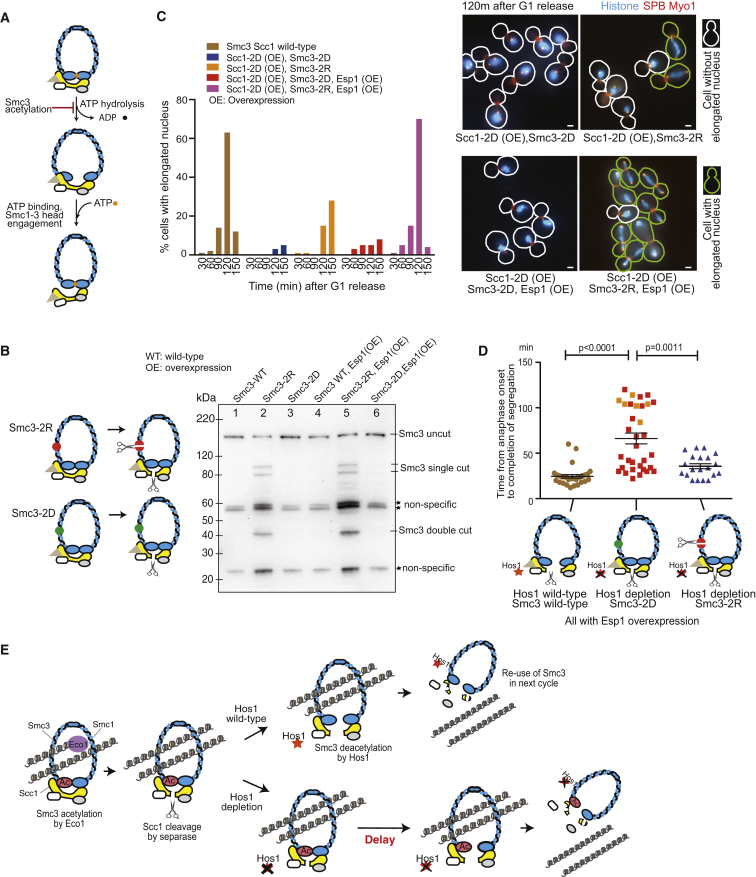
Engineered Smc3 Cleavage by Separase Rescues Efficient Chromosome Segregation in Hos1-Depleted Cells(A) Diagram shows that Smc3 acetylation inhibits ATPase activity of Smc1-Smc3 heads, and Smc1-Smc3 heads remain engaged until ATP is hydrolyzed (top) (Beckouët et al., 2016, Çamdere et al., 2015, Elbatsh et al., 2016, Huber et al., 2016, Murayama and Uhlmann, 2015). In the absence of Smc3 acetylation, ATP is hydrolyzed and Smc1-Smc3 heads are disengaged (middle). Subsequent ATP binding leads to opening of the Smc3-Scc1 interface and destabilizes cohesin association with chromosomes (bottom).(B) Cleavage products are detected in cells carrying SMC3 with separase cleavage sites (SMC3-2R) but not in control (SMC3-2D). Cells with SMC3 wild-type (T12975), SMC3-2R (T11116), SMC3-2D (T11117), SMC3 wild-type PGAL-ESP1 (T12976), SMC3-2R PGAL-ESP1 (T12892), and SMC3-2D PGAL-ESP1 (T12893) were grown in YPA medium containing raffinose. Expression of ESP1 was induced by addition of galactose for 2.5 hr. In all cells, SMC3 wild-type and mutants were tagged with myc epitopes at their C terminus, and the original untagged wild-type SMC3 was deleted, while the original ESP1 was intact. Smc3 was detected by western blotting with an anti-myc antibody.(C) Engineered Smc3 cleavage by separase could rescue chromosome segregation in the presence of Scc1 non-cleavable mutant (SCC1-2D), and this rescue was more efficient when separase was overexpressed. SMC3-2D (T12201), SMC3-2R (T12200), SMC3-2D PGAL-ESP1 (T12827), and SMC3-2R PGAL-ESP1 (T12825) cells with PGAL-SCC1-2D, HTB2-CFP, SPC42-mCherry, and MYO1-mCherry were released from G1 arrest to YPA medium with raffinose. Galactose was added for the last 30 min during G1 arrest and subsequent release from G1 to express SCC1-2D (and to overexpress ESP1 in relevant strains). In all these cells, the original wild-type SMC3 was deleted, while the original ESP1 was intact. Control SMC3 SCC1 wild-type cells (T11219) were treated in the same way. Elongated nuclei were defined as those with two SPBs apart > 3.0 μm; their percentage is shown in graph (left). In representative images at 120 min after release from G1 (right), cells with elongated nuclei are highlighted with green outlines.(D) Engineered Smc3 cleavage by separase rescues timely chromosome segregation in Hos1-depleted cells. HOS1 SMC3 wild-type (T12986), hos1-aid SMC3-2D (T12565), and hos1-aid SMC3-2R (T12566) cells with PGAL-ESP1, HTB2-CFP, Spc42-mCherry, and Myo1-mCherry were treated, and images were acquired as in Figure 1C. Time from anaphase onset to completion of chromosome segregation was plotted as in Figure 1C. Orange squares are as in Figure 1C. p values were obtained by t test.(E) Summary of the outcomes of Smc3 deacetylation by Hos1. Top: Scc1 cleavage by separase prompts deacetylation of Smc3 by Hos1 (Beckouët et al., 2010, Borges et al., 2010, Chan et al., 2013), which in turn facilitates disengagement of Smc1-Smc3 heads (Beckouët et al., 2016, Çamdere et al., 2015, Elbatsh et al., 2016, Huber et al., 2016, Murayama and Uhlmann, 2015), leading to efficient removal of cohesins from chromosomes and rapid dissolution of sister chromatid cohesion (current study). Deacetylated Smc3 is re-used in the next cell cycle (Beckouët et al., 2010, Borges et al., 2010, Xiong et al., 2010). Bottom: Without Hos1, Smc3 acetylation remains in anaphase after cleavage of Scc1 by separase, causing a delay in removal of cohesin from chromosomes and in dissolution of cohesion. Acetylated Smc3 cannot be used in the next cell cycle.See also Figure S4.